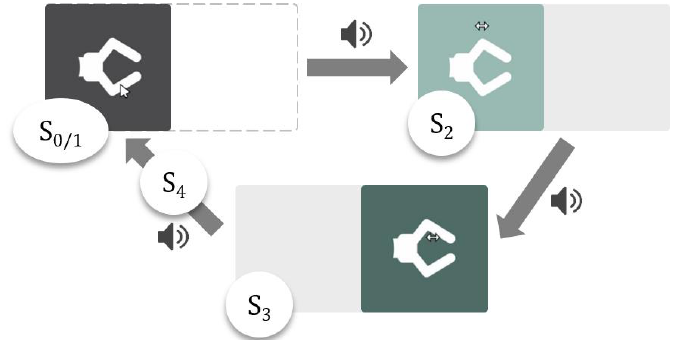
Figure 8. Slide Button. The following steps are necessary for successful activation: When the button is in its neutral state ( S 0 ) the mouse cursor has to dwell in the button ( S 1 ) until visual and acoustic feedback occurs. Then, the button has to be moved to the right along the rail ( S 2 ). At the end of the rail visual and acoustic feedback is given. Next, the button has to be moved to the left along the rail ( S 3 ). When the button reaches the initial position ( S 4 ), it is activated and the assigned action is